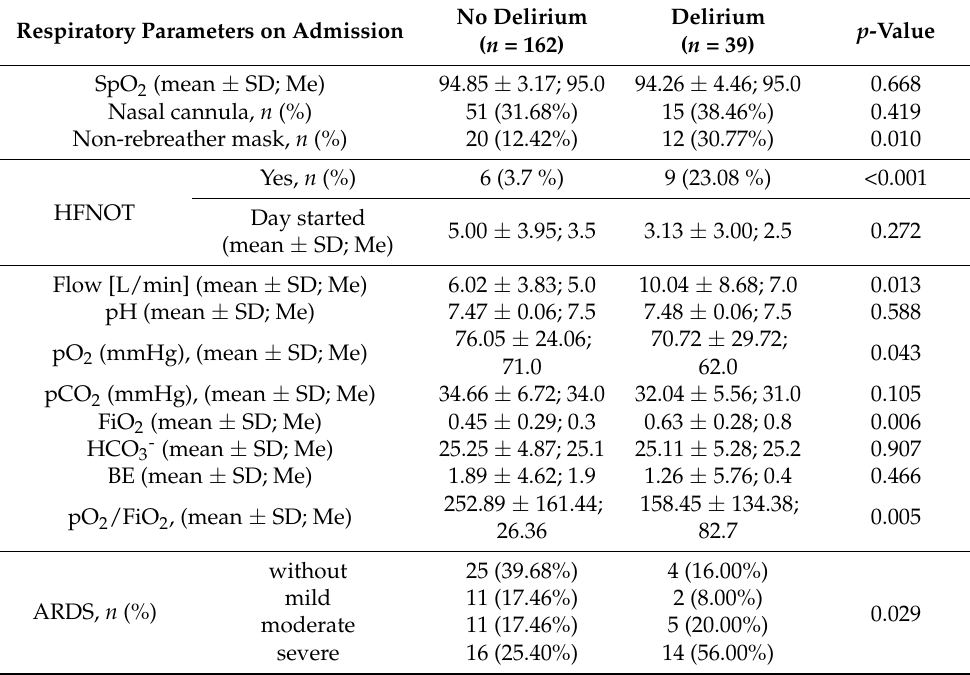
Table 5. Respiratory parameters on